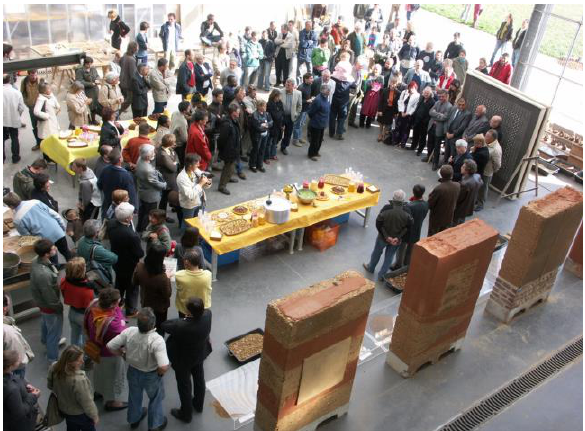
Figure 2. Inauguration of the Grains d’Isère Festival with the presence of local politicians © CRAterre